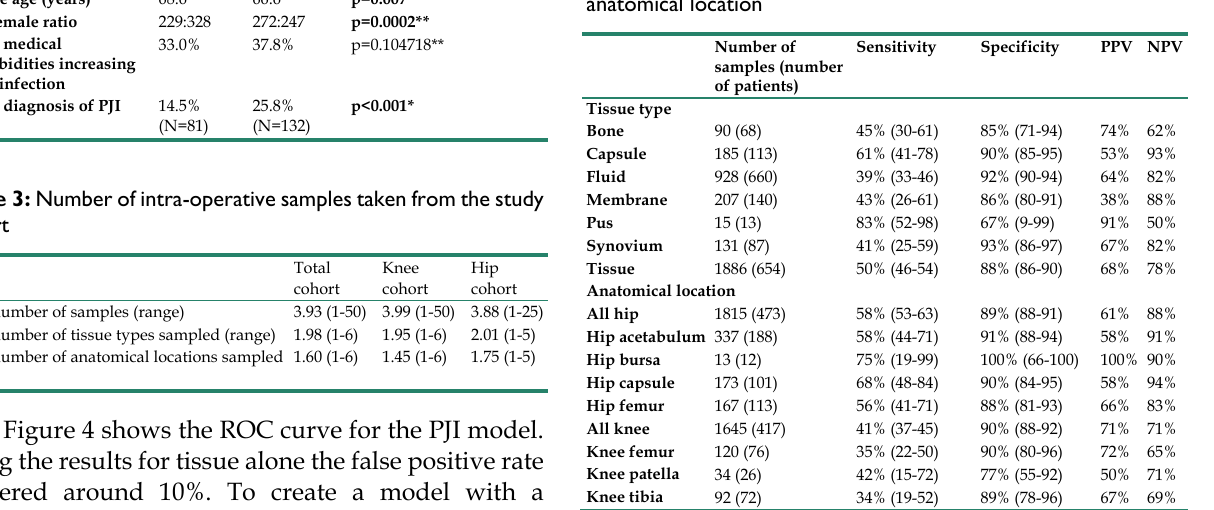
Table 2: Patient demographics of hip and knee surgery cohorts Hip surgery (n